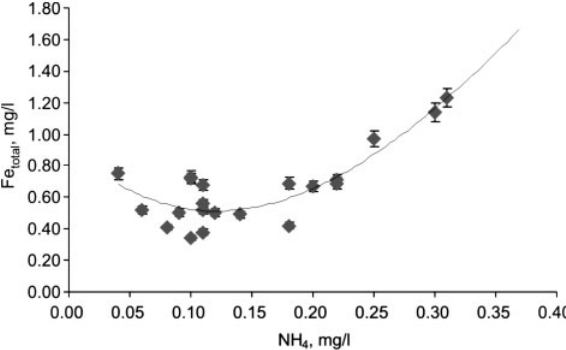
Fig. 3. Dependency between ammonium ions and total iron concentrations in Vilnius network sampling points